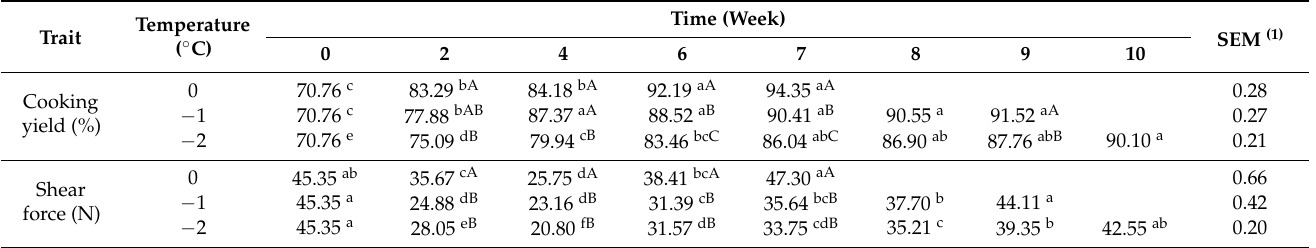
Table 5. Cooking yield and shear force of dry-aged beef loin on 0, − 1, − 2 ◦ C temperature electric field refrigerate